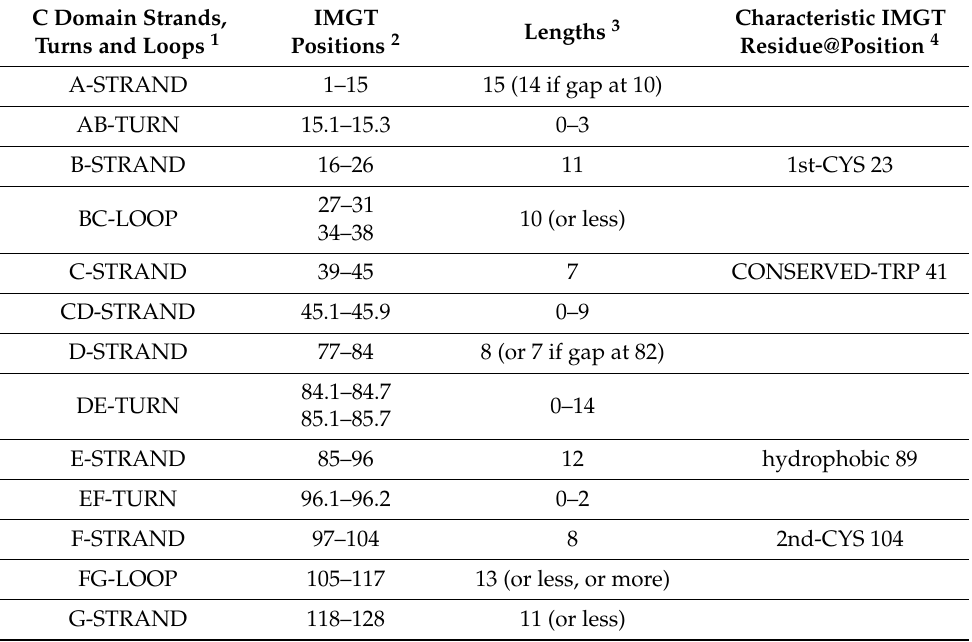
Table 12. C domain strands, turns and loops and IMGT positions and lengths, based on the IMGT unique numbering for C domain (C-DOMAIN and C-LIKE-DOMAIN)